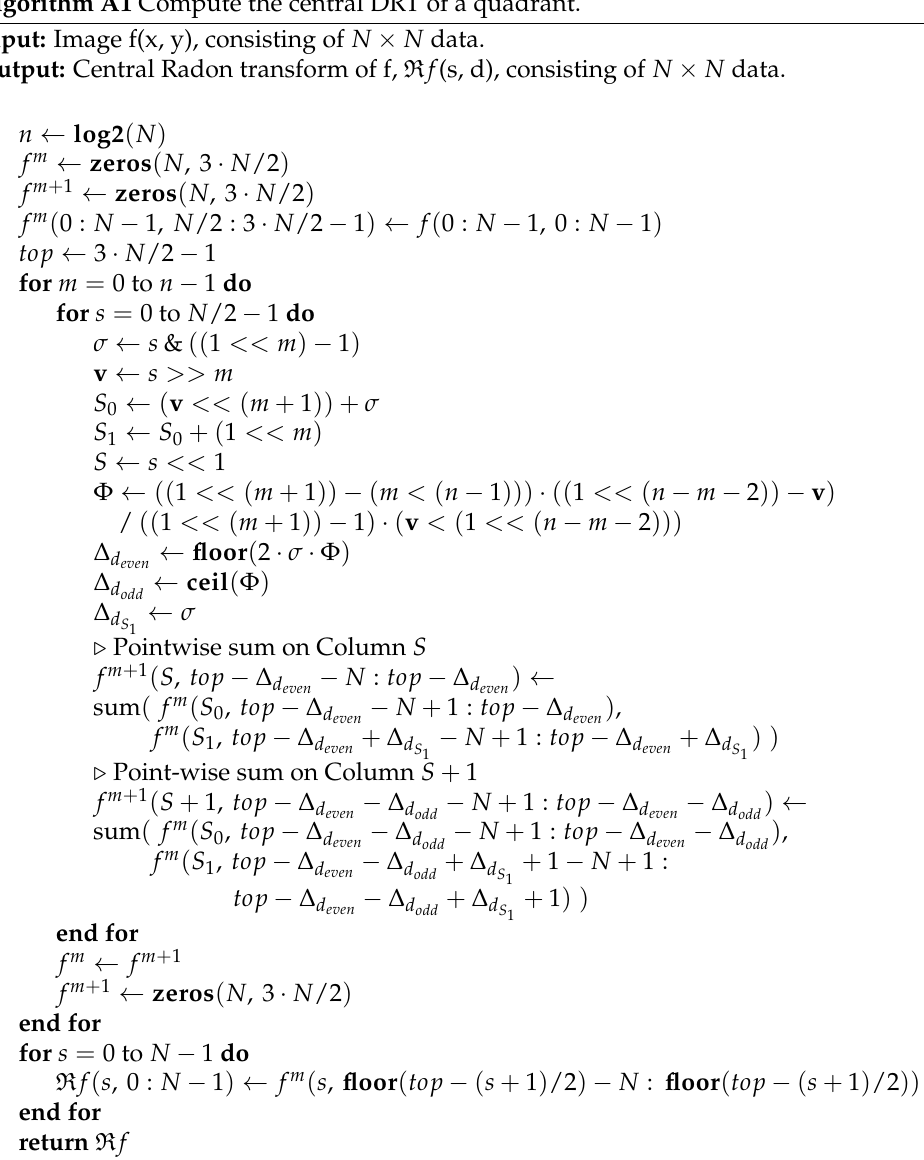
Algorithm A1 Compute the central DRT of a